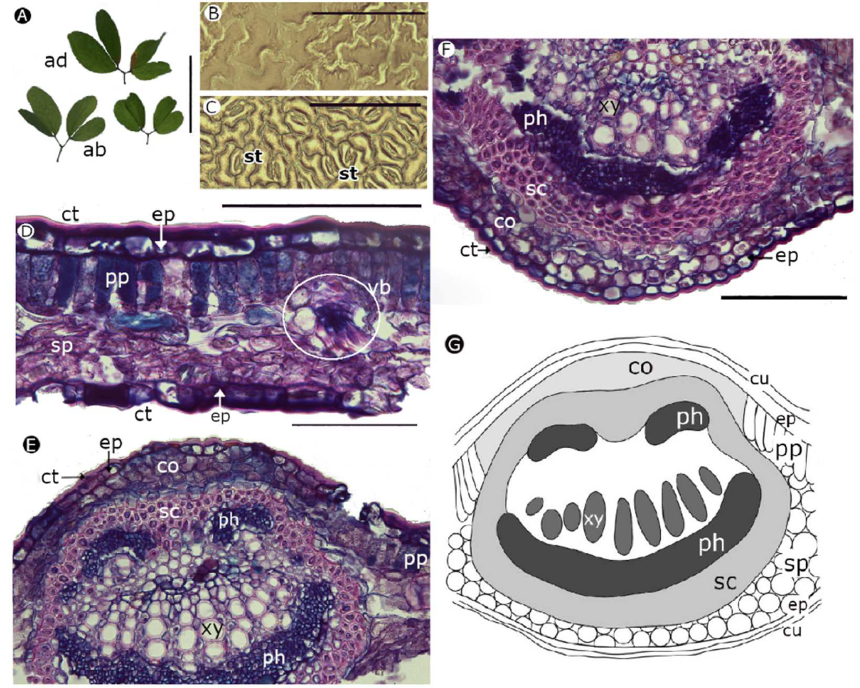
blade, ( E ) and ( F ) midrib, and ( G ) diagram of midrib organization and part of leaf blade. (ab: abaxial;